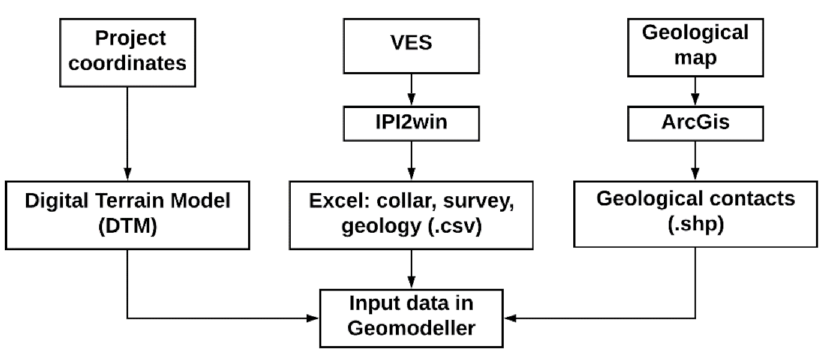
Figure 4. Input data schema in the GeoModeller